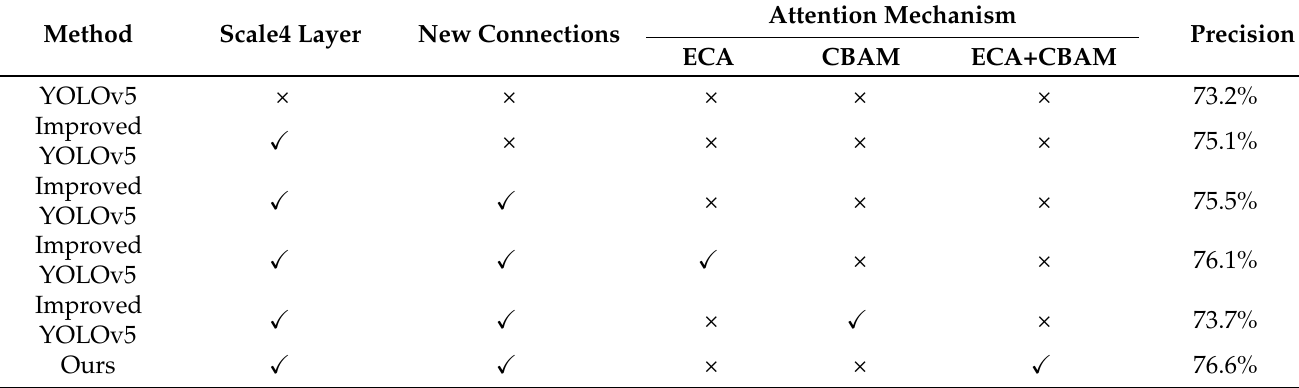
Table 4. The results of ablation study. In the first column, the “YOLOv5” detection method in the first row refers to the original YOLOv5 model; the “improved YOLOv5” in the second row refers to the model that adds the new feature fusion layer to YOLOv5; the third row refers to the model that further adds new connections into YOLOv5 to bring shallow features from backbone network for feature fusion; the fourth row refers to the model that applies ECA attention mechanism to model of the third row; the fifth row refers to the model that applies the CBAM attention mechanism to the model of the third row; and the sixth row refers to our proposed model that applies the combined ECA and CBAM attention mechanism to the model of third